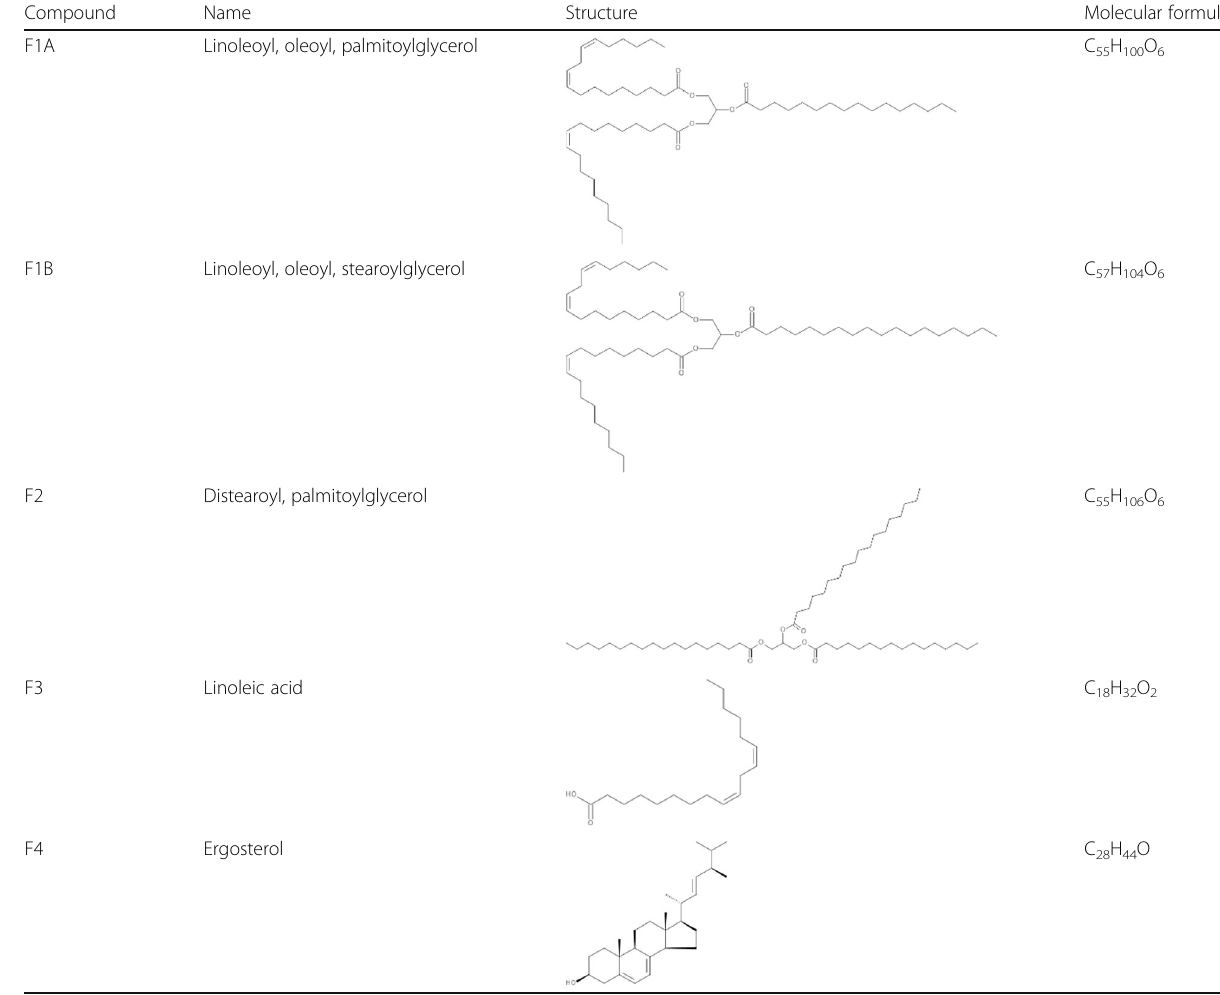
Table 4 Name, structure and molecular formula of constituent compounds of APH crude extract Compound Name Structure Molecular